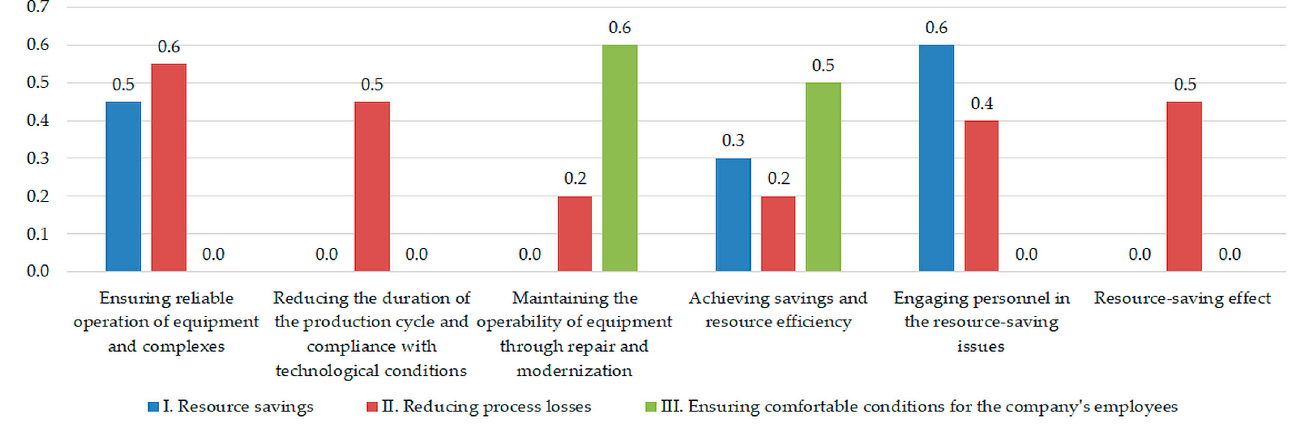
Figure 7. Assessment of the degree of influence of the “Contrasting Priority Scenarios” level on the elements of the “Actors’ Targets” level.